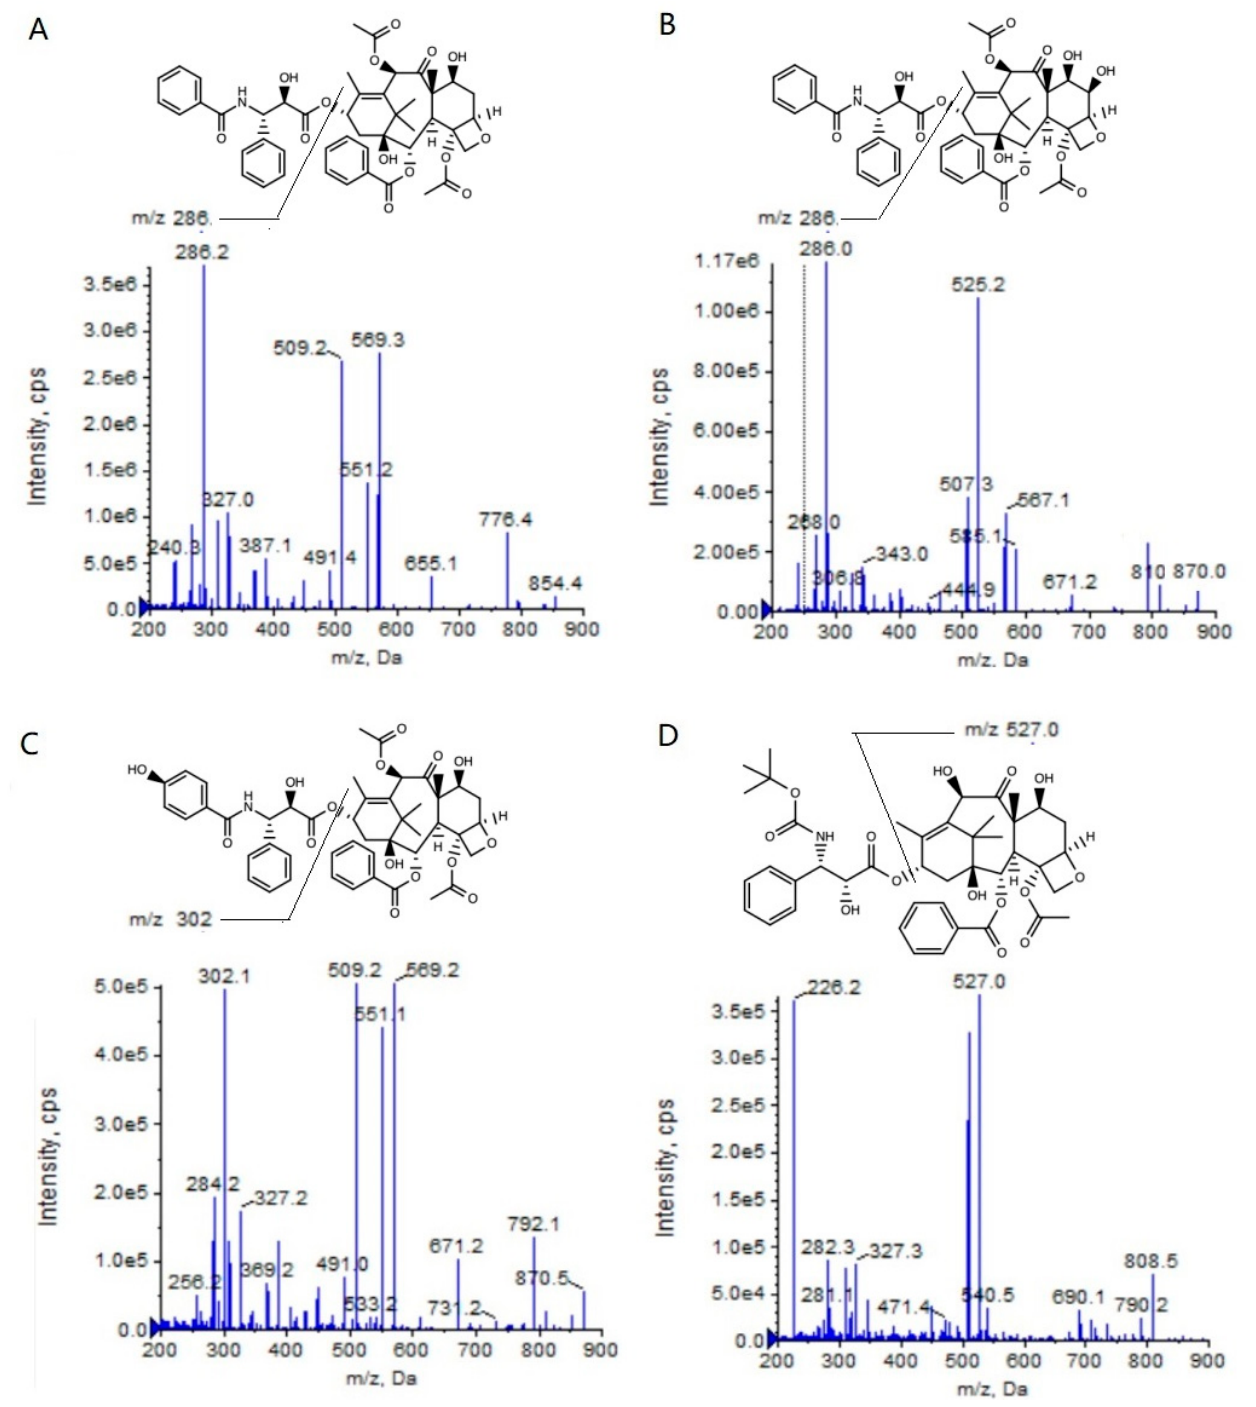
Figure 1. Product ion mass spectra of PTX ( A ), 6 α‐ OHP ( B ), 3 ′‐ OHP ( C ), and DTX ( D ).